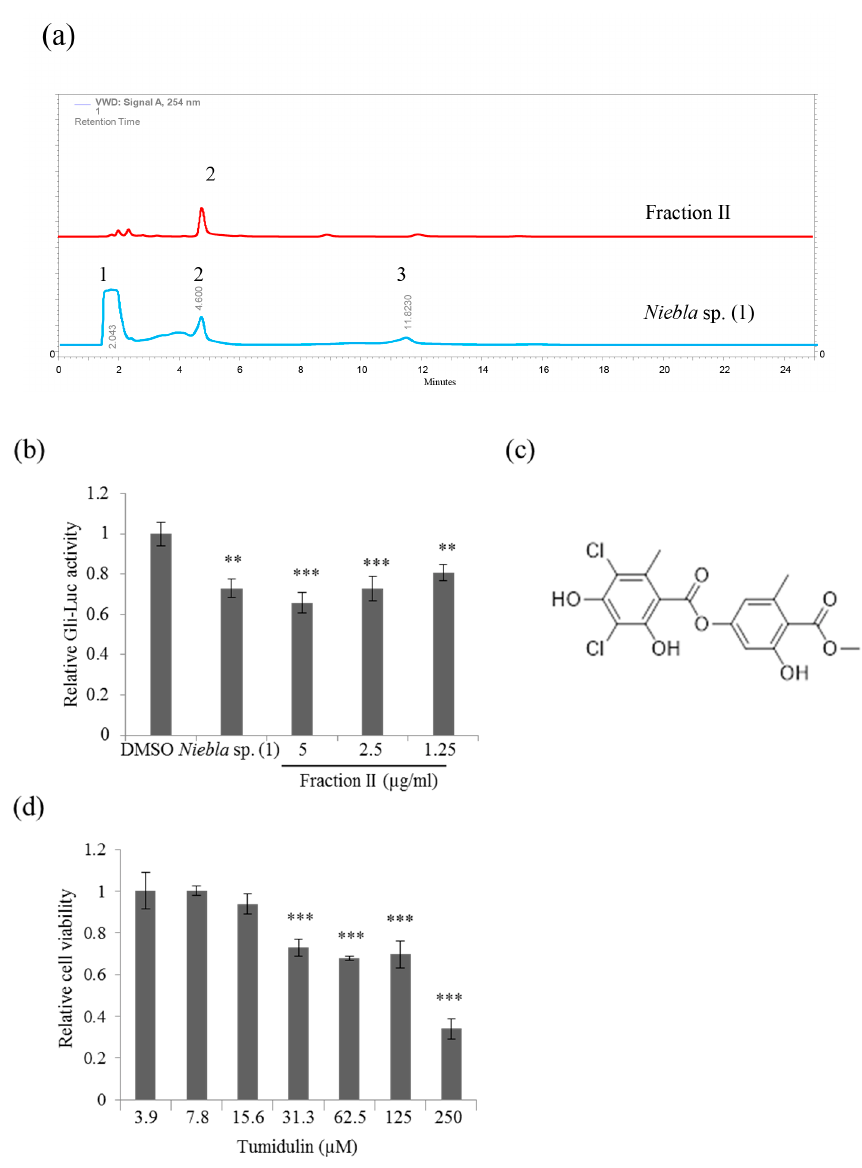
Figure 2. Tumidulin is an active lichen secondary metabolite from Niebla sp. (1) that inhibits CSC221 cell stemness. ( a ) High-performance liquid chromatography (HPLC) analysis of the inhibitory activity of stemness in CSC221 cells by crude and active Niebla sp. (1) fractions using a methanol:water:phosphoric acid (80:20:1, v / v / v ) solvent system. ( b ) Quantitative analysis of reporter assays of NIH 3T3 cells treated with a 5 µg/mL acetone extract of Niebla sp. and various concentrations of the active (tumidulin) fraction for 48 h. ( c ) Chemical structure of tumidulin. ( d ) Relative viability of CSC221 cells treated with tumidulin for 48 h by MTT assay. Quantitative data were obtained from three independent experiments ( n = 3). Data represent mean ± SEM, and analysis was performed by one-way ANOVA. ** p < 0.01 and *** p < 0.001 compared with DMSO-treated CSC 221 cells.